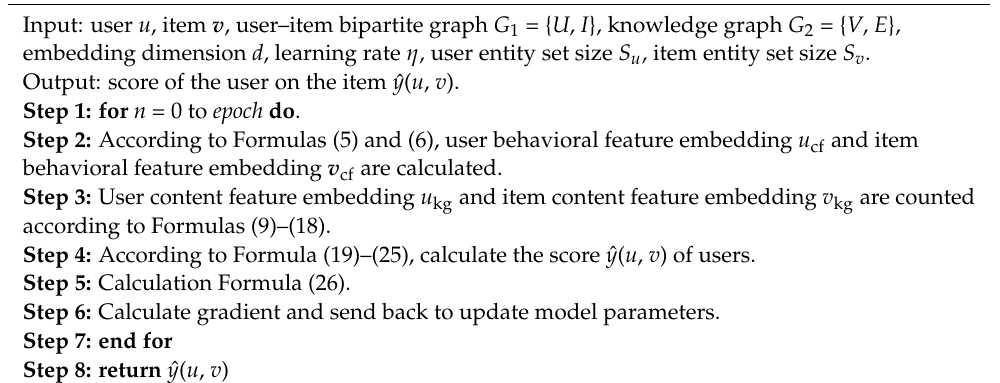
Algorithm 1: Knowledge graph recommendation model based on feature space